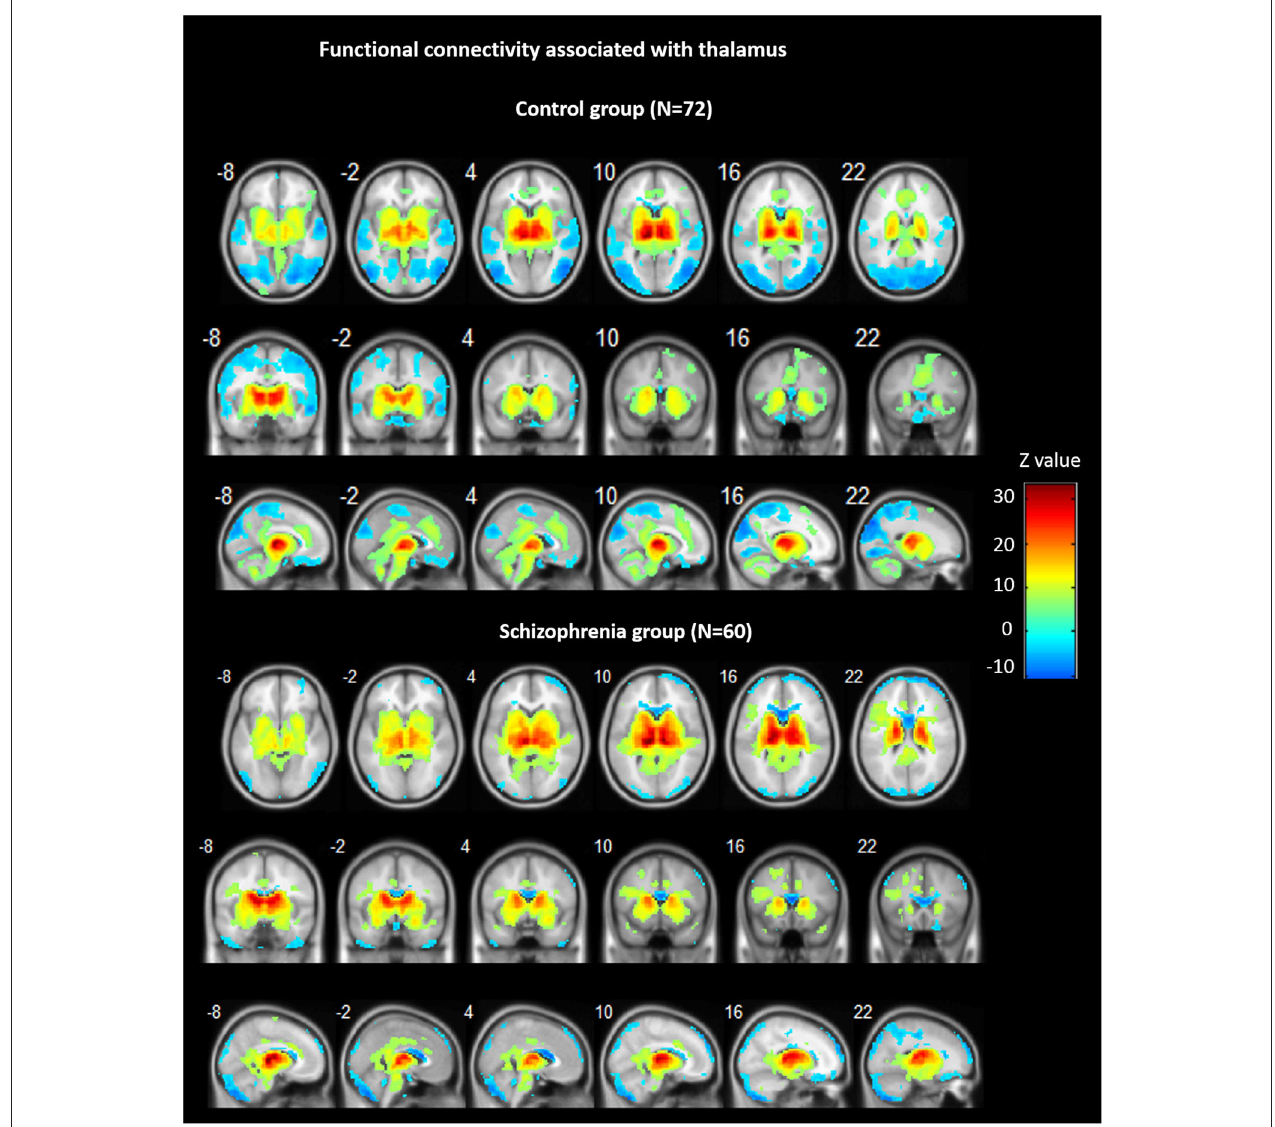
FIGURE 1 | Functional connectivity (FC) associated with the thalamus in schizophrenia and in controls . Hot color represents positive FC with thalamus, whereas blue cold color represents negative FC. Images are in radiologic format with subject left on image